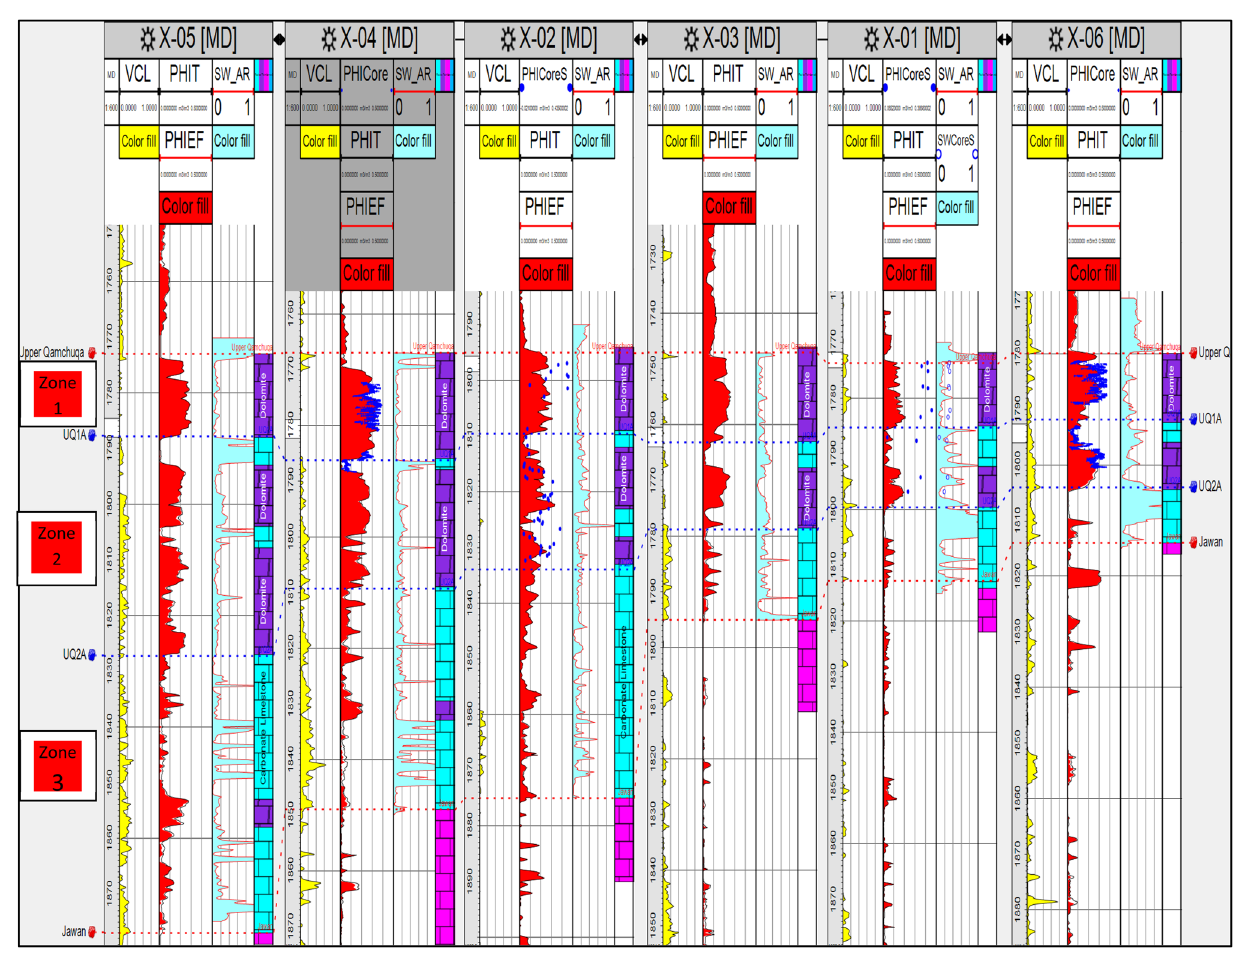
Fig. 2 Reservoir zonation base on well correlation